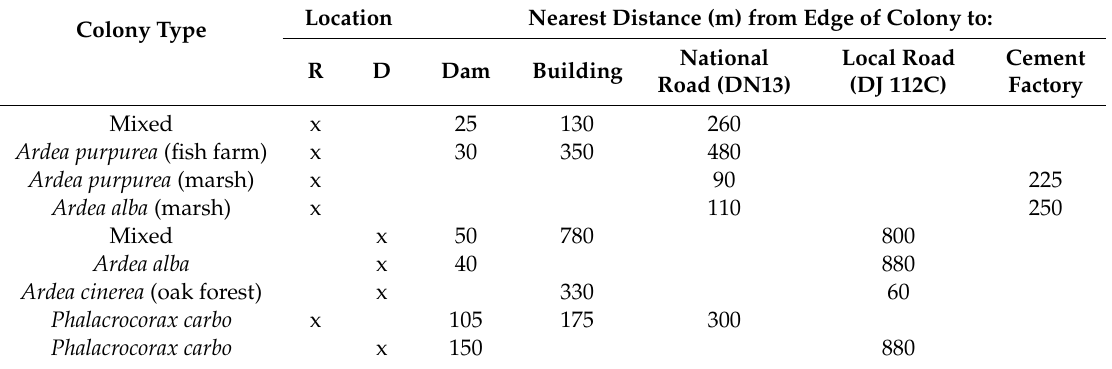
Table 2. Nearest distance (m) from colony edge to terrestrial habitats and human